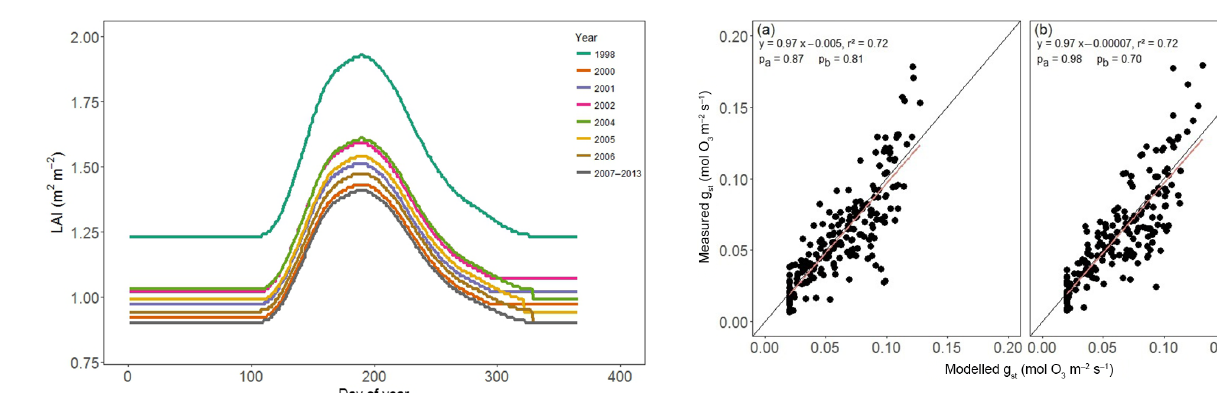
Figure 3. The seasonal course of the LAI for each of the 14 growing seasons used in this study.